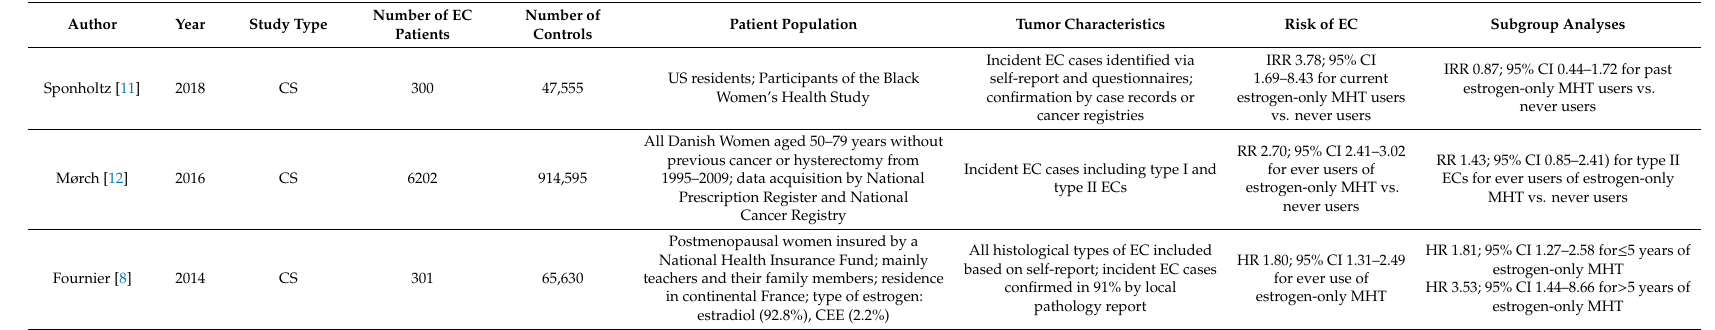
Table 4. Clinical Characteristics of Studies Reporting on Estrogen-Only MHT in Women with an Intact Uterus and EC